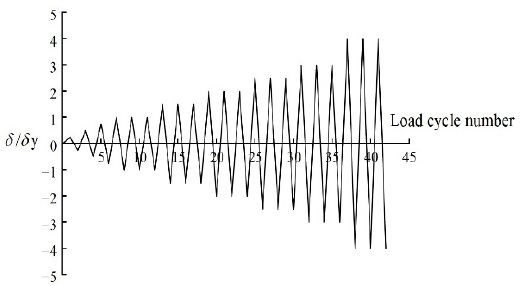
Figure 3. Loading